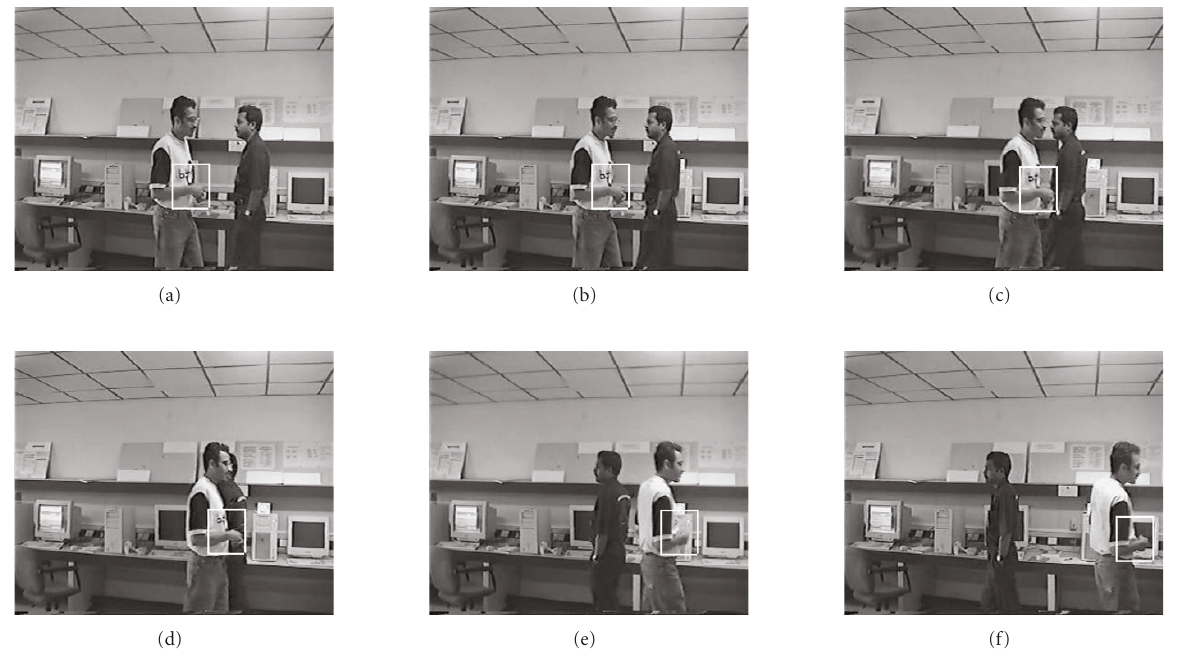
Figure 14: Results on tracking a hand (at t = 4,6,10,14,25,35) in a video sequence where 2 men are crossing each other.